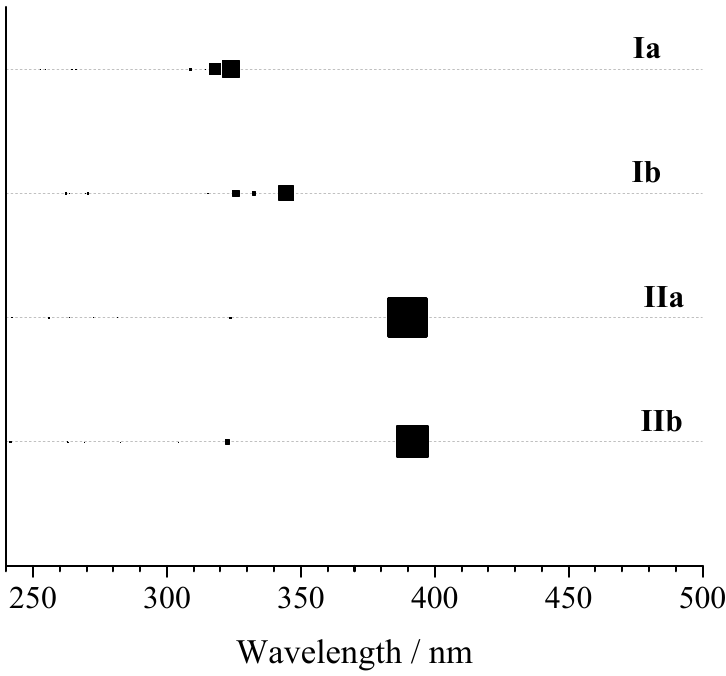
Figure 2. TD-B3LYP(SMD = water)/aug-cc-pVDZ//M062X/cc-pVDZ absorption wavelengths and oscillator strengths predicted for models Ia (C 2 symmetry), Ib (C 2 symmetry), IIa (C s symmetry), and IIb (C s symmetry). The size of the square symbols reflects the oscillator strength.